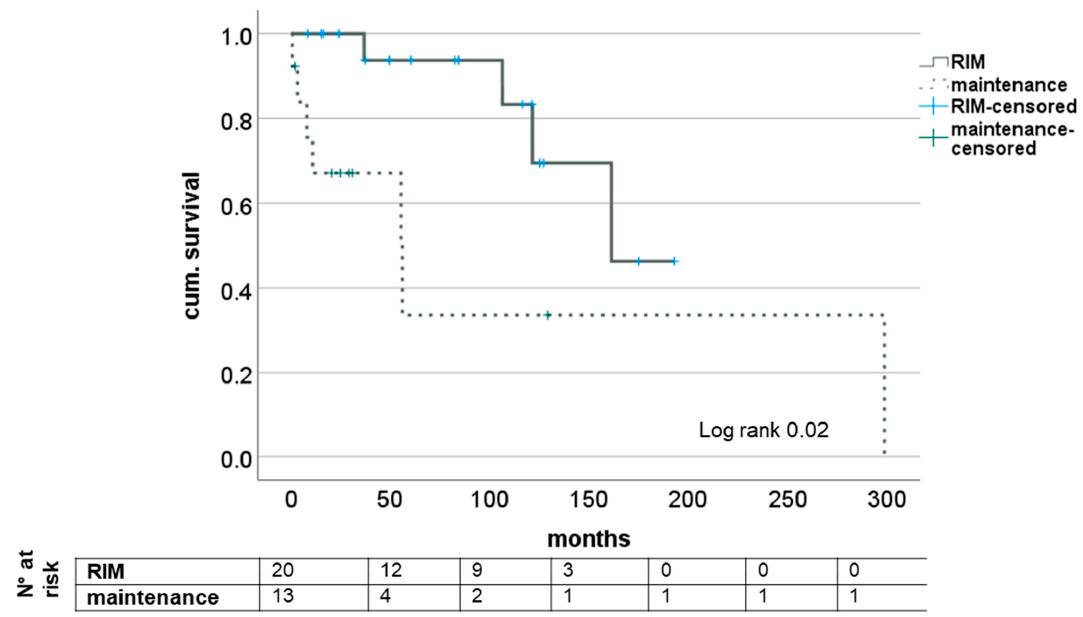
Figure 1. Impact of RIM on survival after diagnosis of de novo CRC after LT. RIM—restrictive immunosuppressive management.